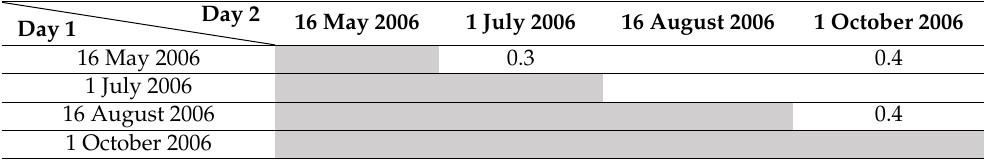
Table 2. PALSAR coherences, track